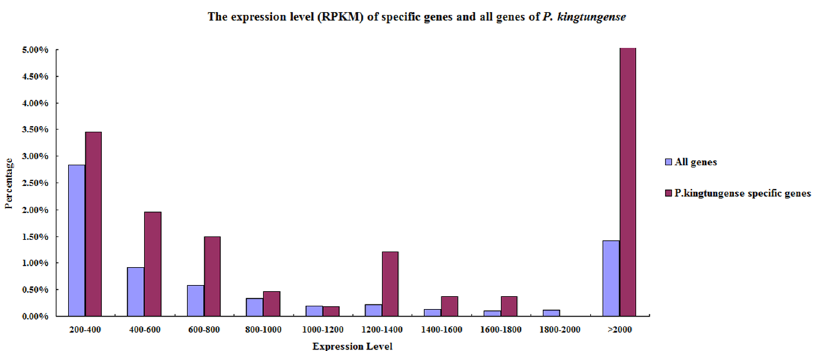
Figure 3. The expression level (RPKM) of specific genes and all genes of P. kingtungense